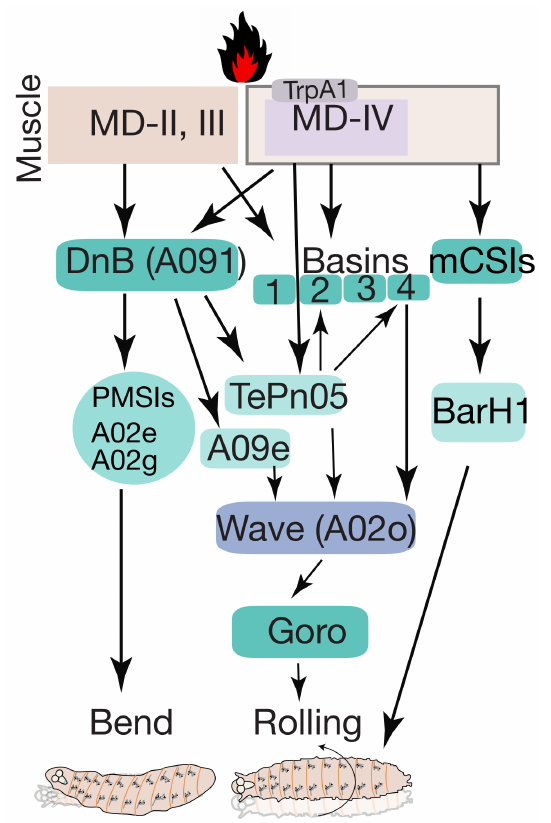
Figure 6. The neural circuits involved in thermo-nociception-mediated bending and rolling. Neural circuits depicting multiple pathways that can be recruited when larvae experience noxious heat (adapted and modified from